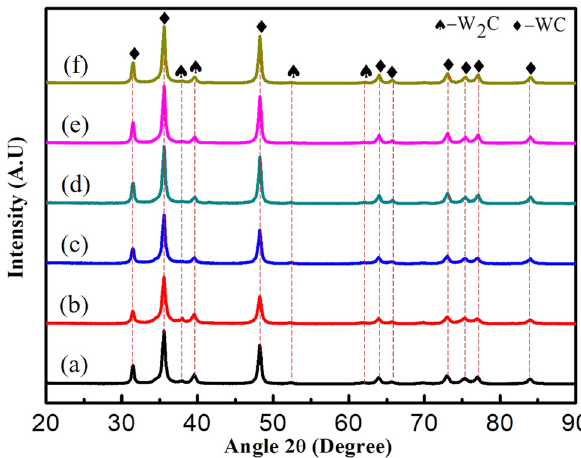
Figure 3: X - ray di ff raction pattern of the WC – Ni composite ceramic specimen: ( a ) WCN - 1#, ( b ) WCN - 2#, ( c ) WCN - 3#, ( d ) WCN - 4#, ( e ) WCN - 5#, and ( f ) WCN -